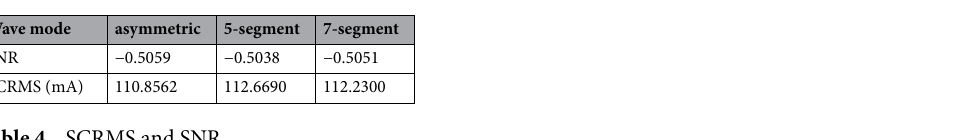
Table 4. SCRMS and